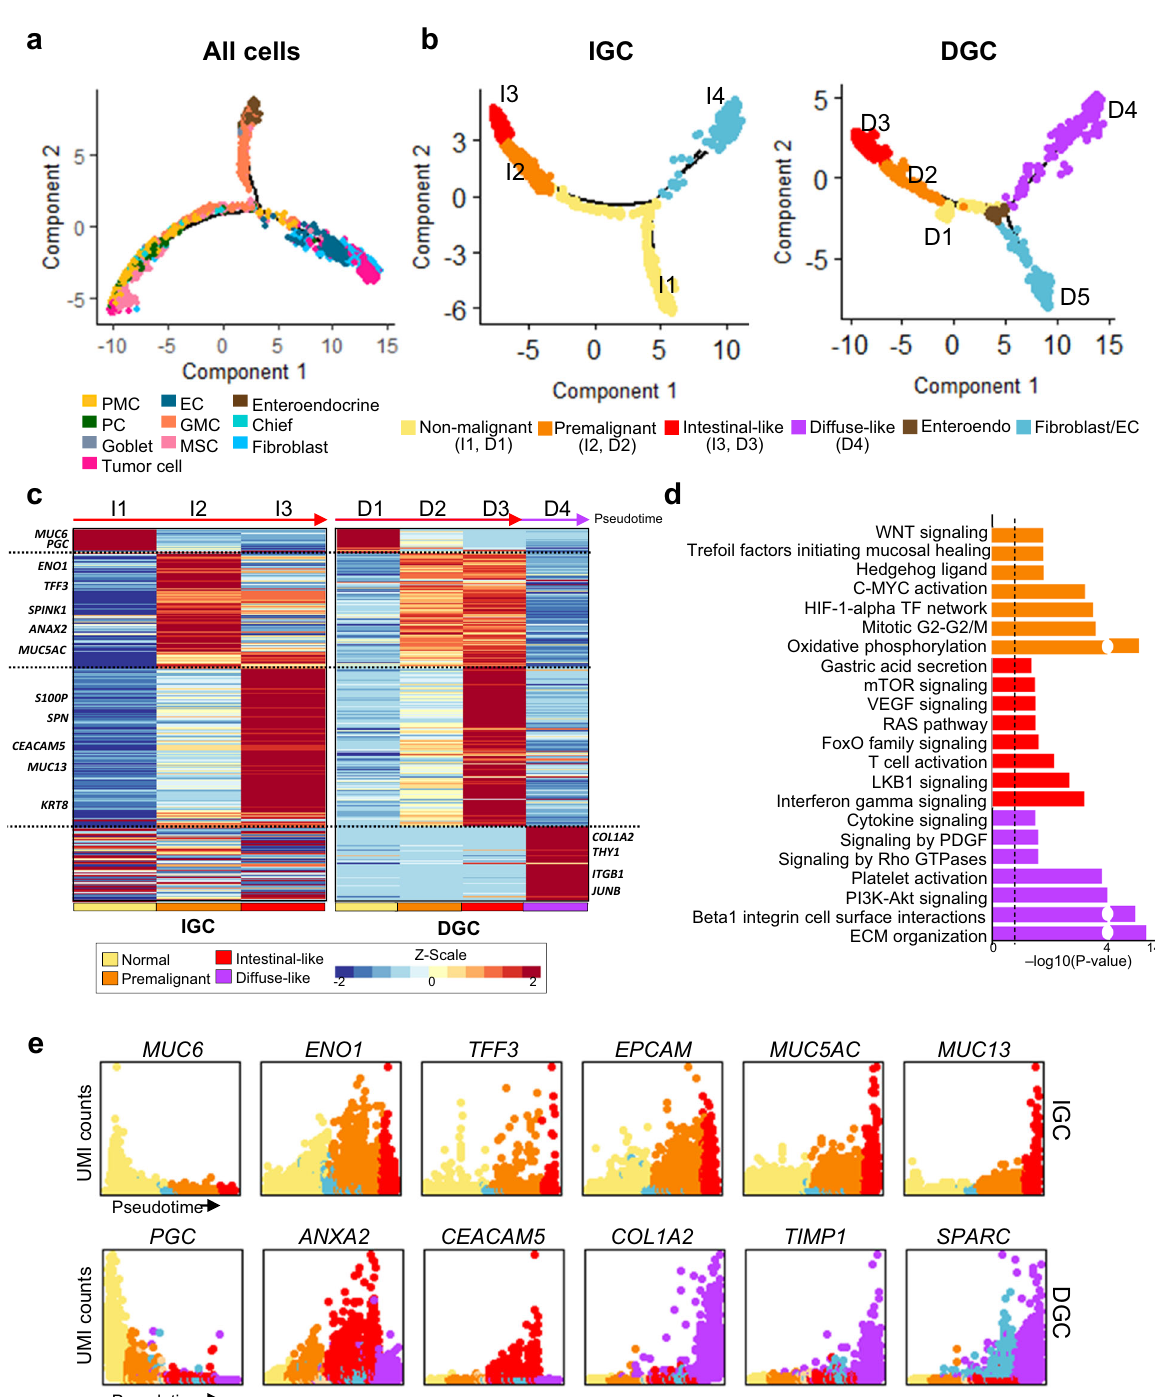
Fig. 2 Tumor cell types determined by pathological classi fi cation and functional features. a Trajectory plot of a total of 13,022 cells. In the trajectory trees, colors represent ten cell types. b Trajectory plots for intestinal gastric cancer (IGC) and diffuse gastric cancer (DGC). Colors represent the malignant process (yellow: non-malignant, orange: premalignant, red: intestinal-like, and purple: diffuse-like) and other cell types (e.g., fi broblasts/ECs and enteroendocrine). The pseudotime increased from the non-malignant (I1 and D1) to the malignant state (I3, D3, and D4), except for fi broblasts and ECs. c Heatmap of differentially expressed genes (DEGs) derived from the malignant process-related states in IGC (I1 – I3) and DGC (D1 – D3 or D1 – D4). Rows of the heatmap show dynamic expression changes of DEGs along the pseudotime, and known marker genes represent both sides in the heatmap. d Bar plots of signi fi cant pathways with DEGs enriched in speci fi c cell states (threshold P < 0.05, black dotted line). P values were calculated by a gene enrichment test. Colors represent the malignant process (orange: premalignant, red: intestinal-like, and purple: diffuse-like). e Expression patterns of known marker genes related to the malignant process. The colors correspond to the malignant process states (orange: premalignant, red: intestinal-like, and purple: diffuse-like). The pseudotime is plotted along the x axis, and UMI gene counts are shown on the Y